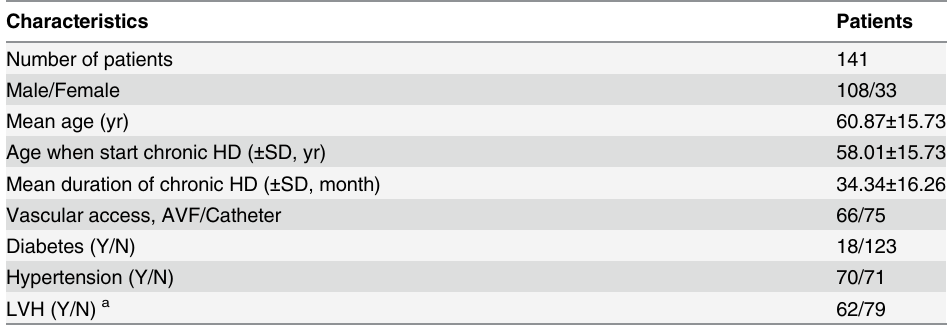
Table 1. Baseline characteristics of the study patients. Characteristics